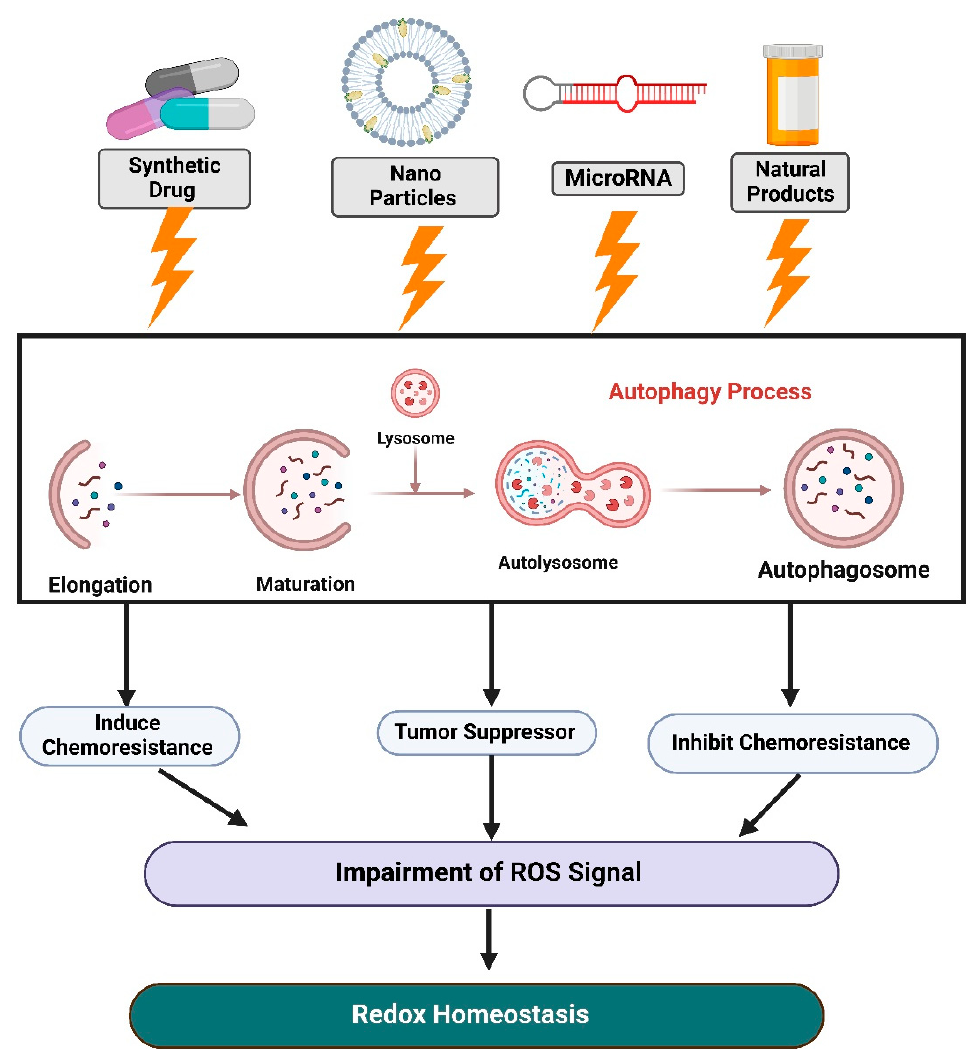
Figure 4. Schematic diagram of the latest findings on redox homeostasis and autophagy in cancer and their potential therapeutic applications. Targets for redox homeostasis and autophagy in cancer include synthetic drugs, natural chemicals, nanoparticles, and microRNA-mediated pathways.